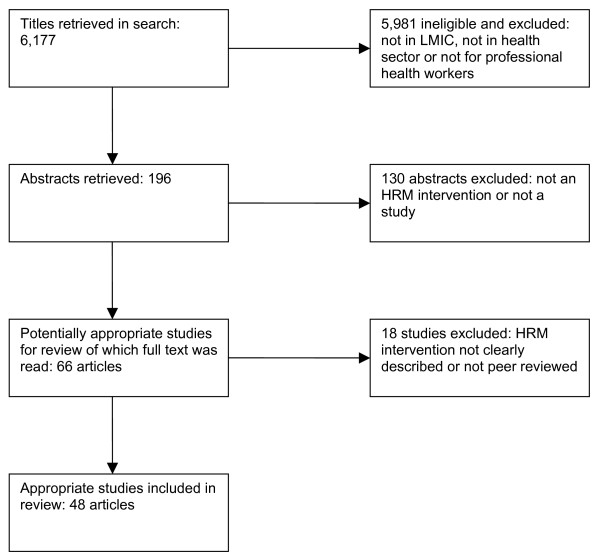
Flowchart of search.